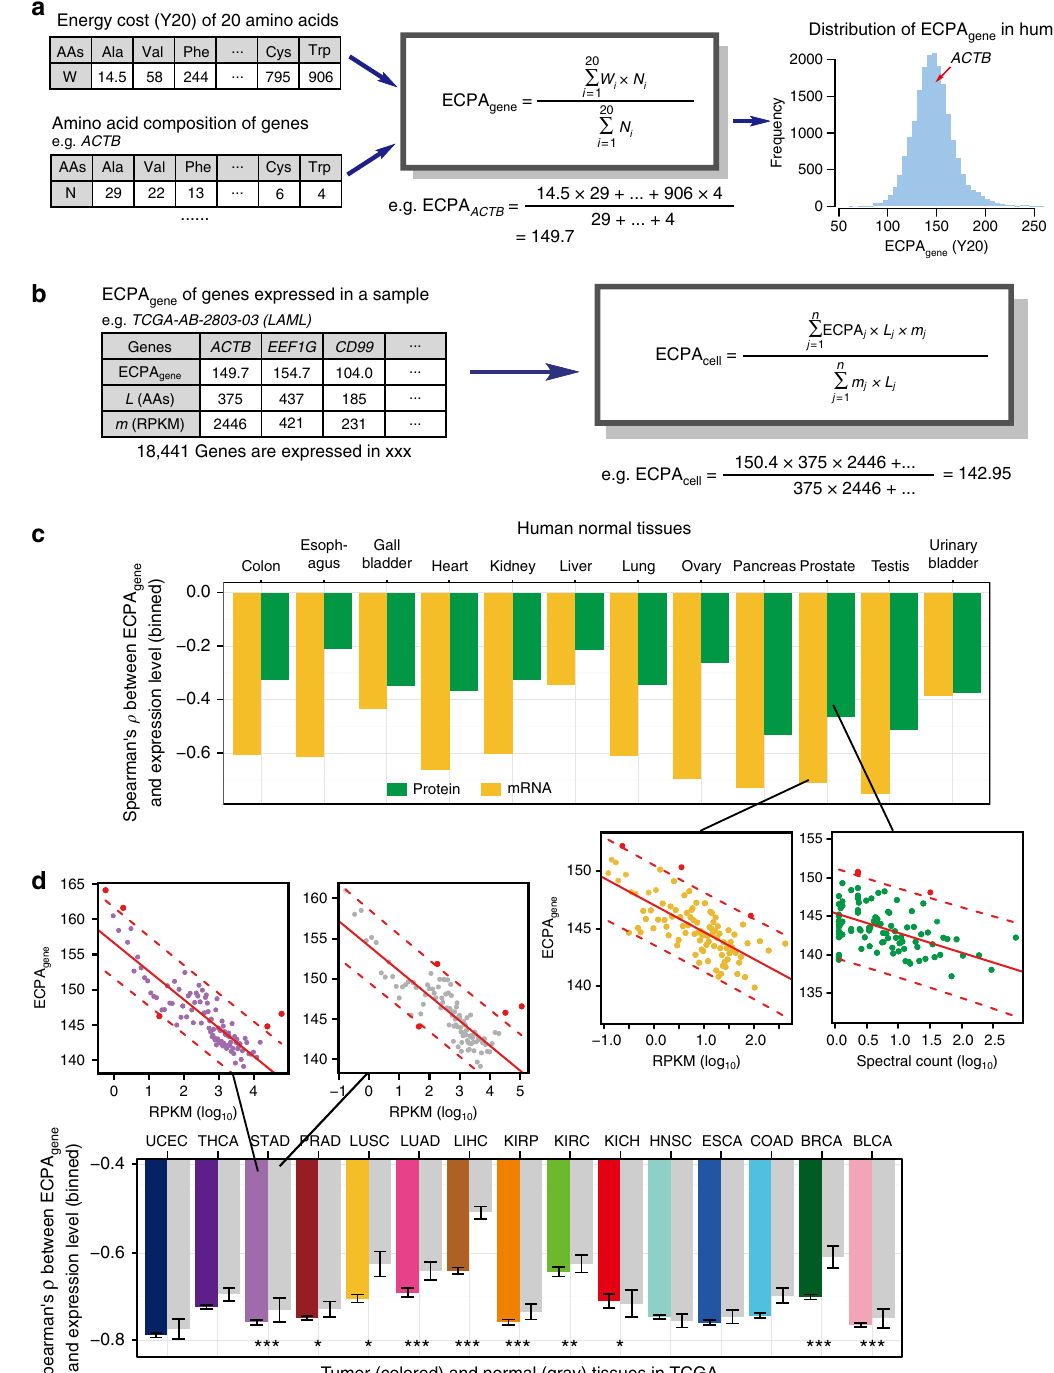
We extended this analysis to the mRNA expression data of The Cancer Genome Atlas (TCGA) 5 and con fi rmed similar signi fi cant negative correlations in both normal and cancer samples (only cancer types with > 10 matched normal – tumor sample pairs were analyzed; Fig. 3d and Supplementary Fig. 7b for Y20, and Supplementary Table 6 for B20 and H11 results). In 9 of the 15 cancer types surveyed, the negative correlation patterns were signi fi cantly stronger in cancer compared with normal tissues (another 4 cancer types showed similar trends, but the differences were not statistically signi fi cant; Fig. 3d). Previous results